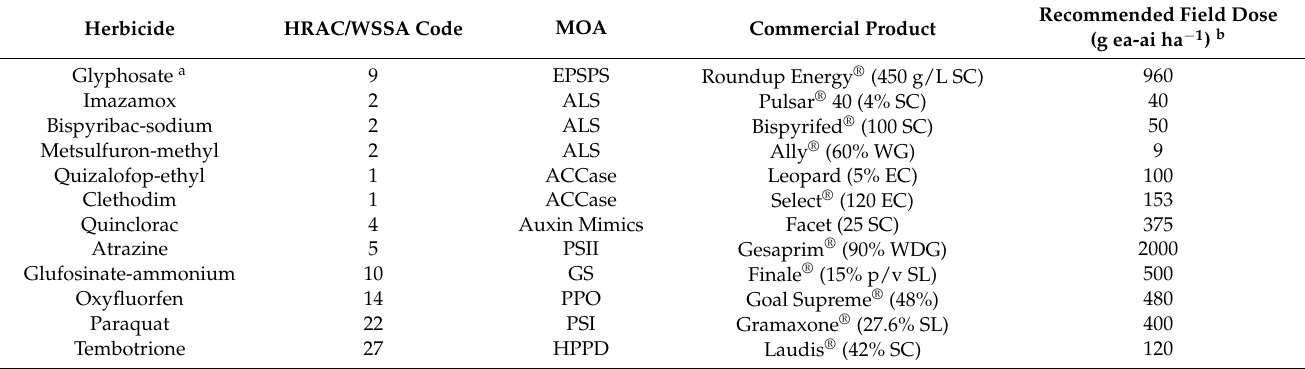
Table 1. Characteristics of commonly used herbicides to control this species (glyphosate and imazamox) and the alternatives herbicides used in “ Integrated chemical management assay